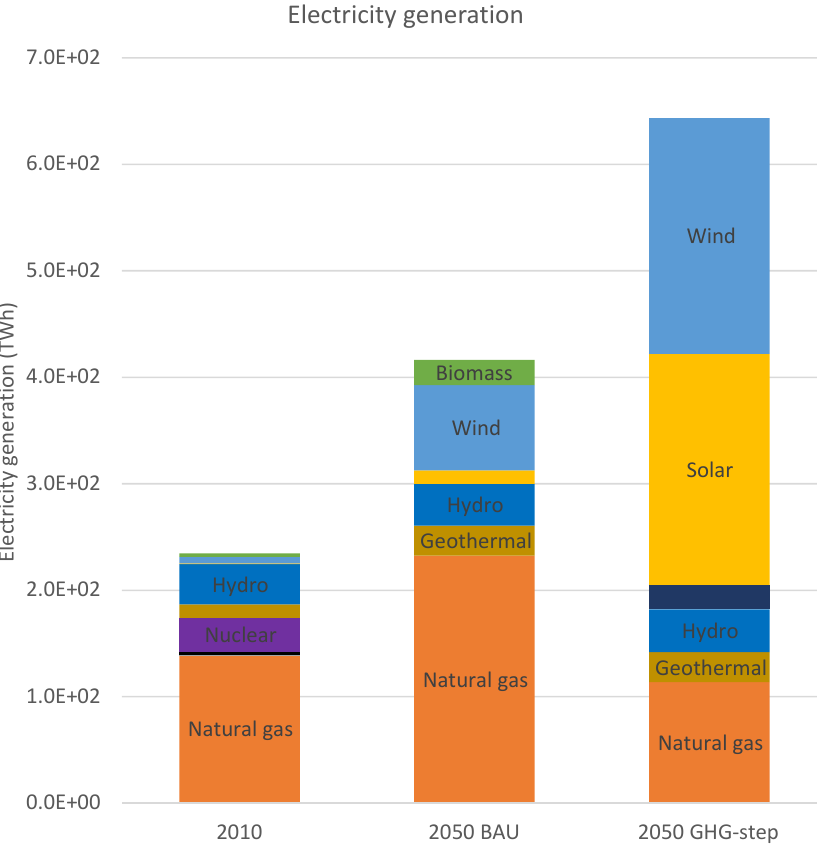
Figure 10. CA-TIMES electricity generation resource mix by